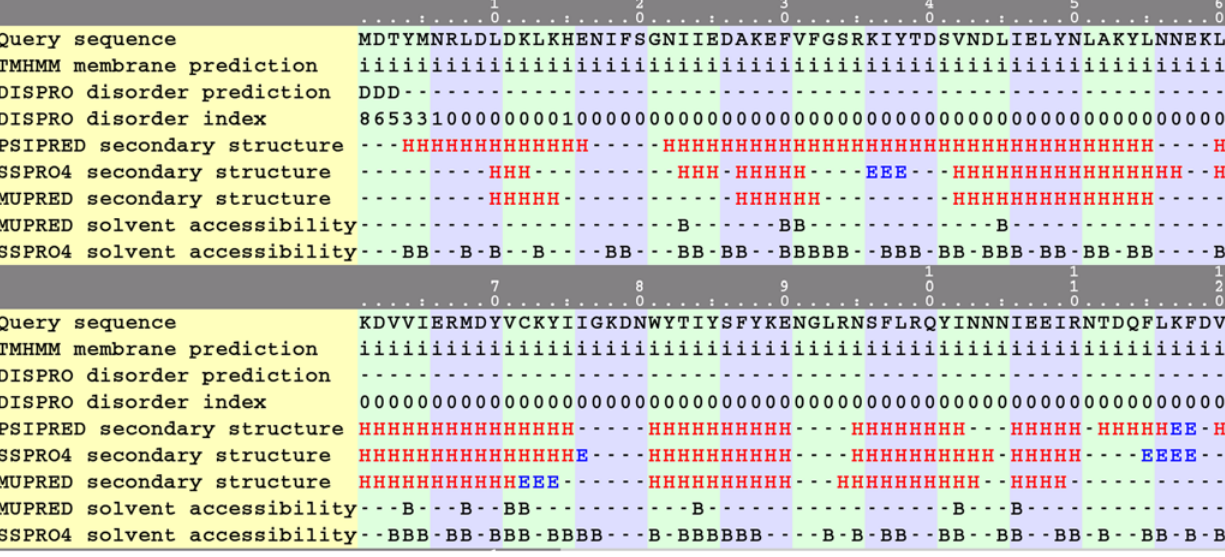
Figure 5. Screenshot of the pipeline-rendered HTML output showing predicted sequence properties for variola protein NP_042054.1. i, intracellular; D, disordered; H, helix; E, strand; B, buried.